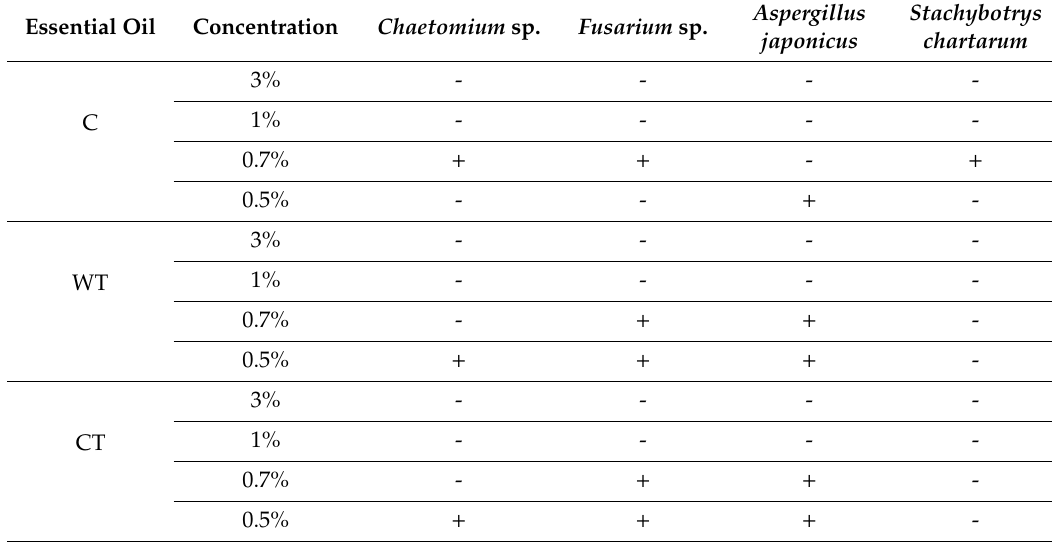
Table 3. Estimation of the minimum inhibitory concentration (MIC) of the EOs. + : presence of growth; -: absence of